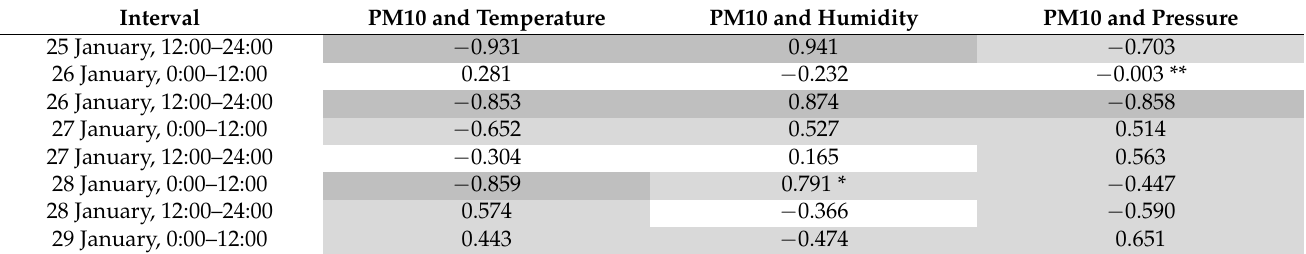
Table 6. Correlation between mass concentration of PM10 and temperature, humidity, pressure: 12-h